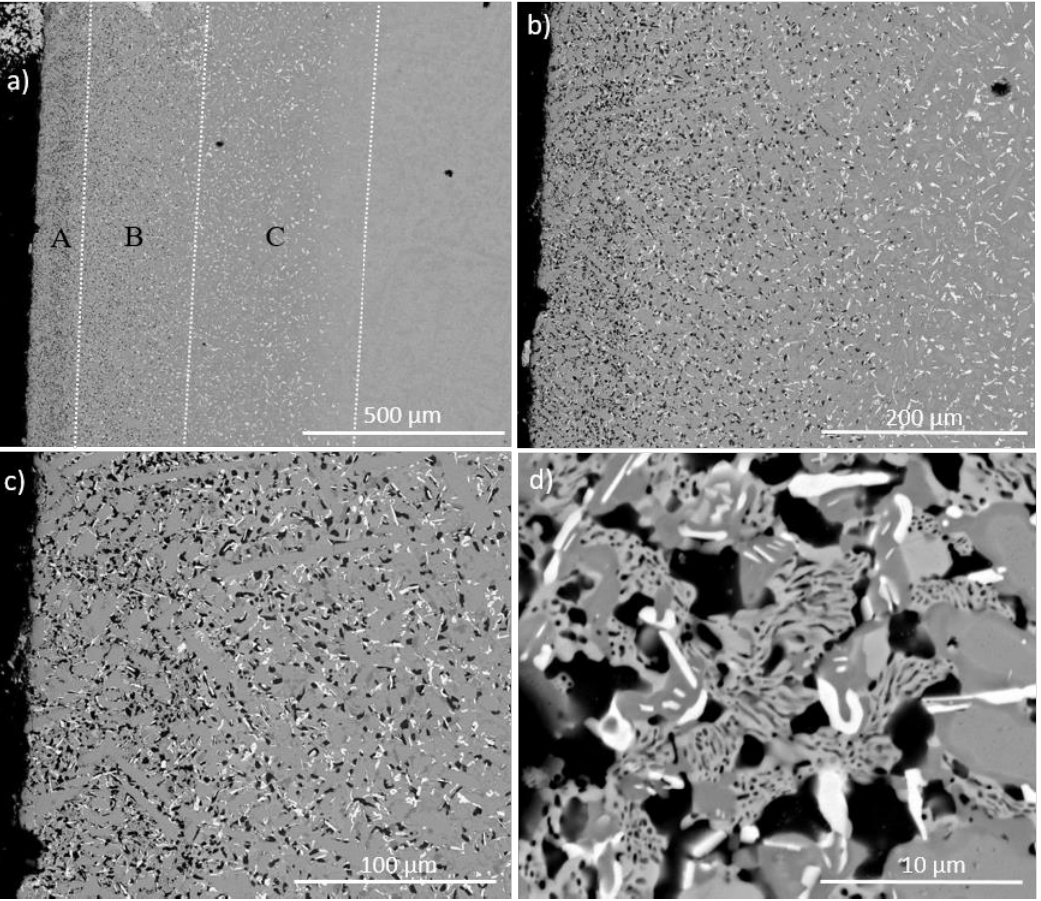
Figure 5. BSE images of cross section of the alloy NbSiTiHf-5Al-5Cr after isothermal oxidation at 1200 °C ( a ) showing overview of the sample and ( b ), ( c ) and ( d ) showing detail at greater magnification.